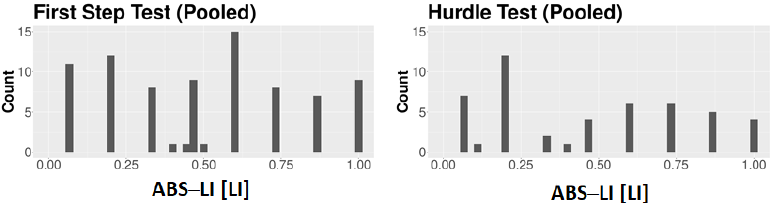
Figure A4. Frequency distribution of the dogs’ ABS–LI data for all the pooled First Step and the pooled Hurdle Test.